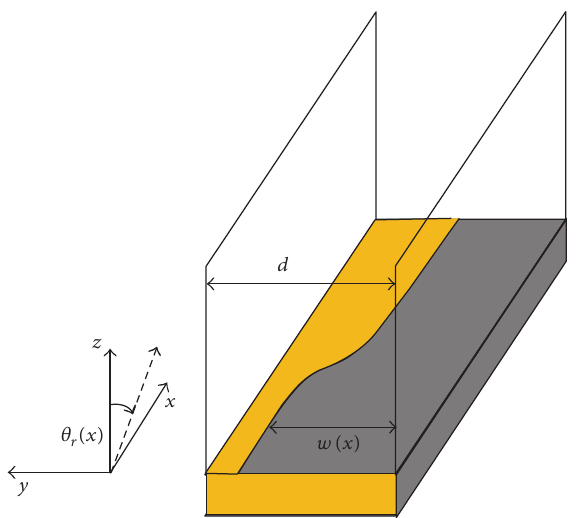
Figure7:Awidth-taperedhalf-widthmicrostripLWlineembedded between two metallic planes